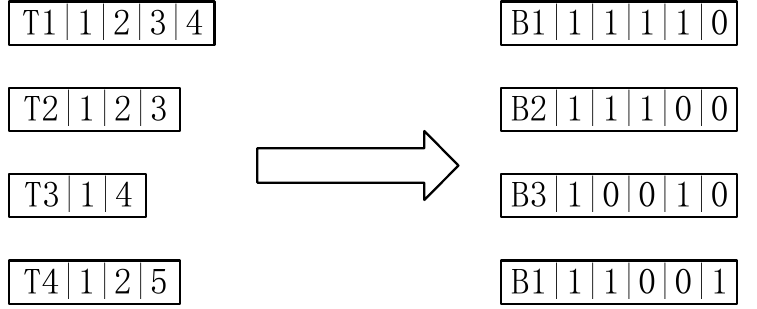
Figure 3. Transaction data binary transformation.